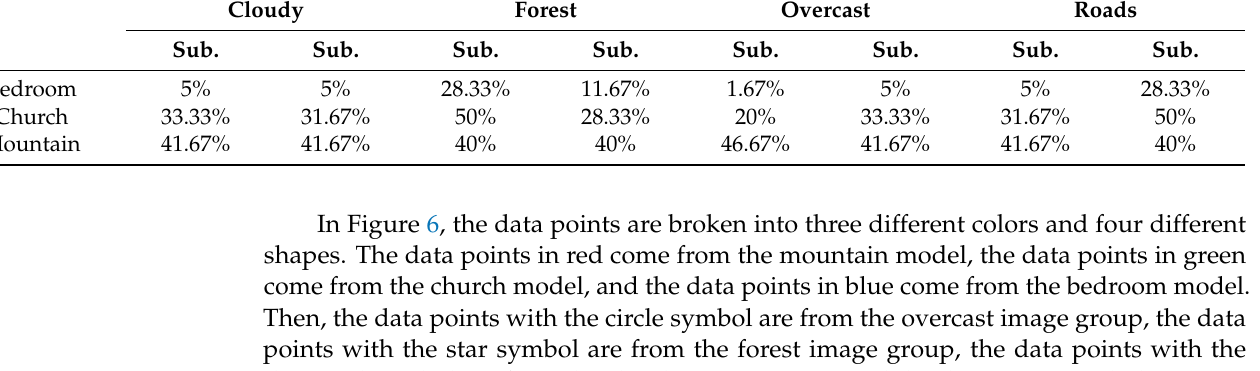
Table 4. Average accuracy when only one attribute is selected from each image. Cloudy Forest Overcast Roads Sub. Sub. Sub. Sub. Sub. Sub. Sub. Sub. Bedroom